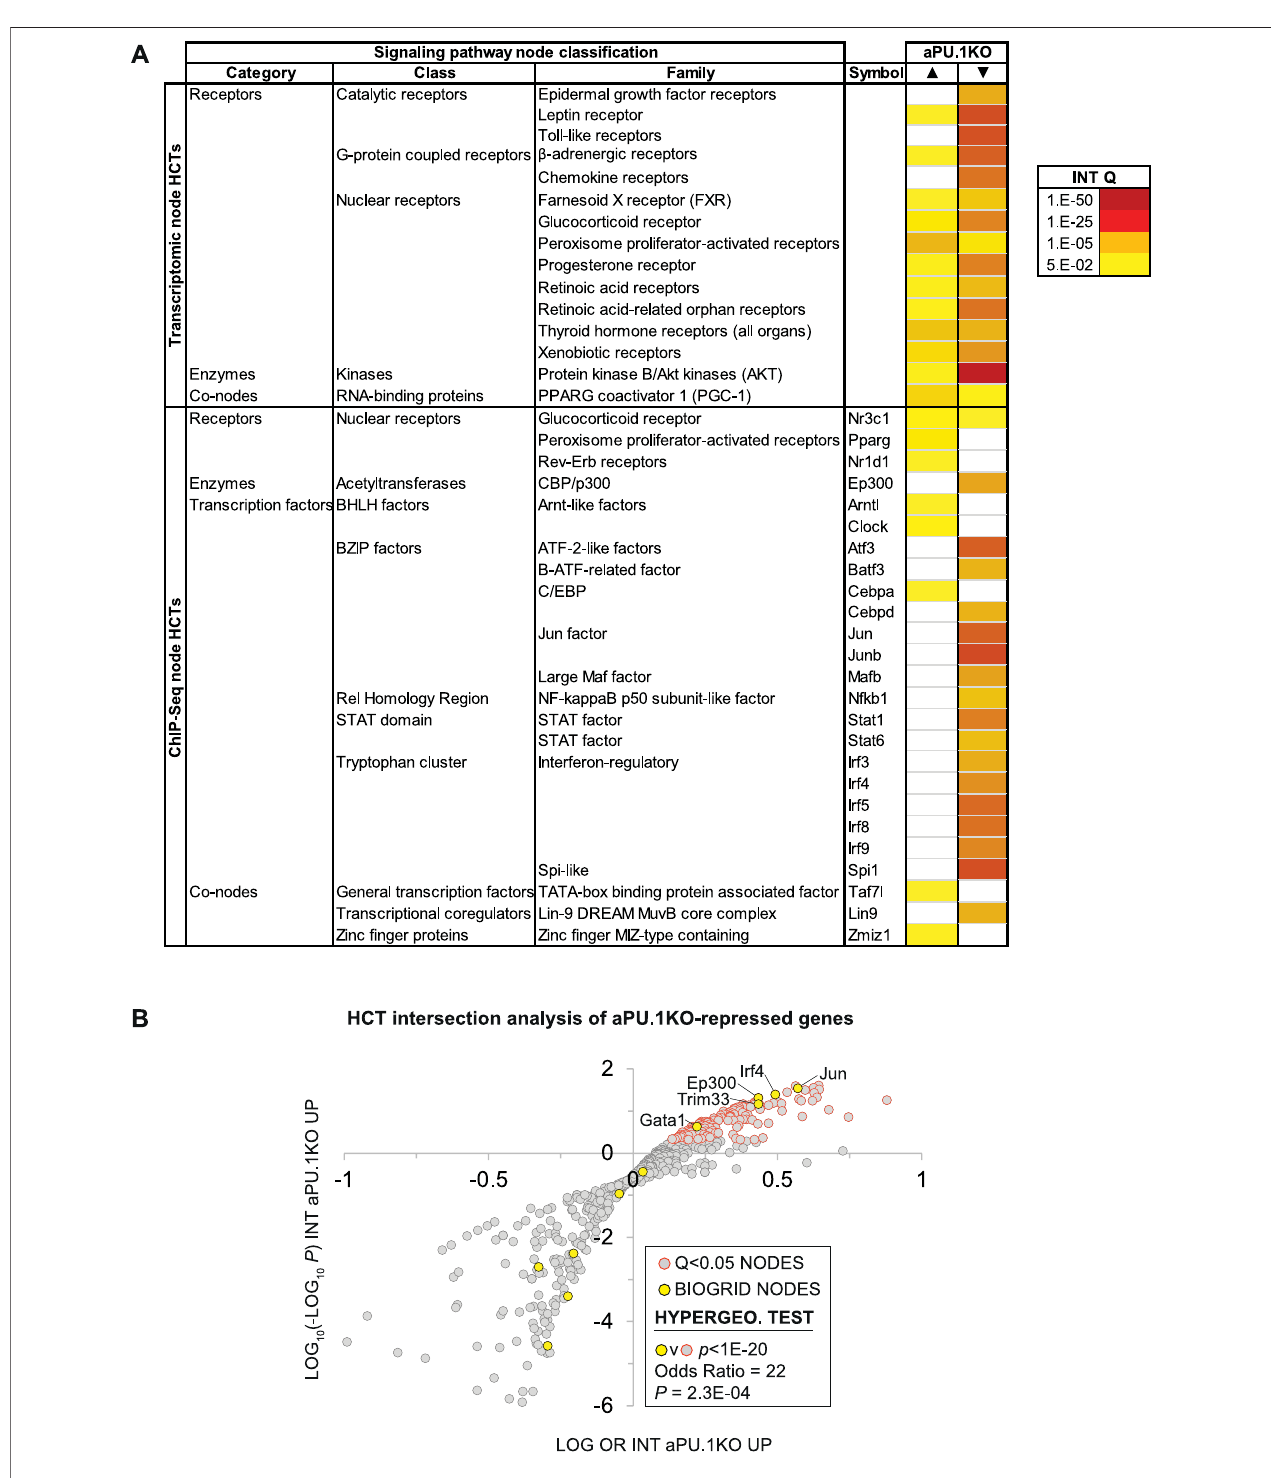
FIGURE 5 | High Con fi dence Transcriptional Target (HCT) Intersection Analysis Identi fi es PU.1-Modulated Metabolic and In fl ammatory Transcriptional Regulatory Hubs. (A) HCT intersection Q-values (INT Q)forselectedsignaling pathway nodes ornode familiesareindicatedintheformofaheatmap. HCT intersection analysiswas carried out as described in the Methods section. White cells represent Q > 5E-2 intersections. The intensity of the color scheme is proportional to the con fi dence of the intersection between high con fi dence transcriptional targets (HCTs) for a particular node and either (i) aPU.1KO-induced ( ▲ ) or (ii) aPU.1KO-repressed ( ▼ ) gene sets.Lowercon fi dence(smallerQ)intersectionsaretowardstheyellowendofthespectrumandhighercon fi dence(largerQ)intersectionsaretowardstheredendofthe spectrum. Full numerical data are in Supplementary Table S2 . (B) Scatterplot showing enrichment of known BioGRID-curated PU.1 interacting nodes among nodes that have the most signi fi cant intersections with aPU.1KO-repressed genes. Refer to the text for details.